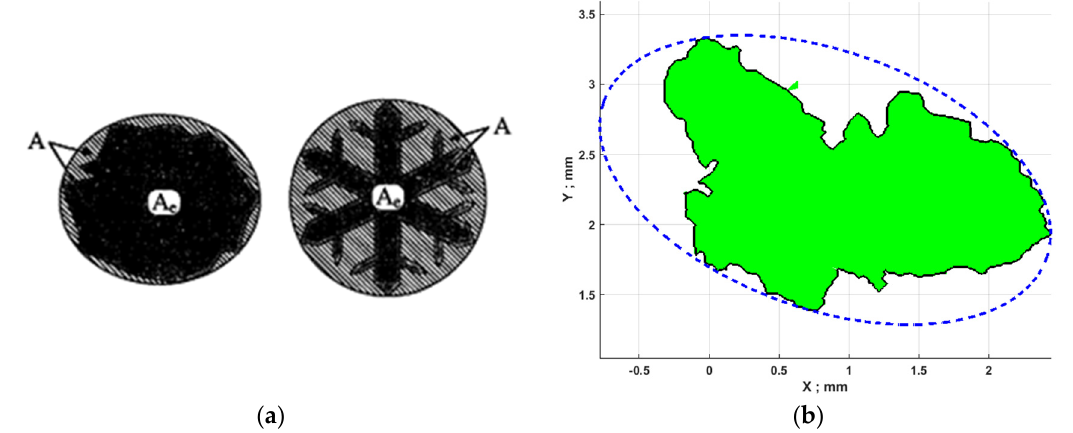
Figure 12. ( a ) Definition of cross-sectional areas A e (the shadowed area) and A (the area of the smallest ellipse completely containing A e —it includes A e and the hatched area) presented to the flow; from [17]; ( b ) Bottom view (normal to the flow) automatically obtained from the reconstructed 3D shape of a snow particle using the visual hull method.